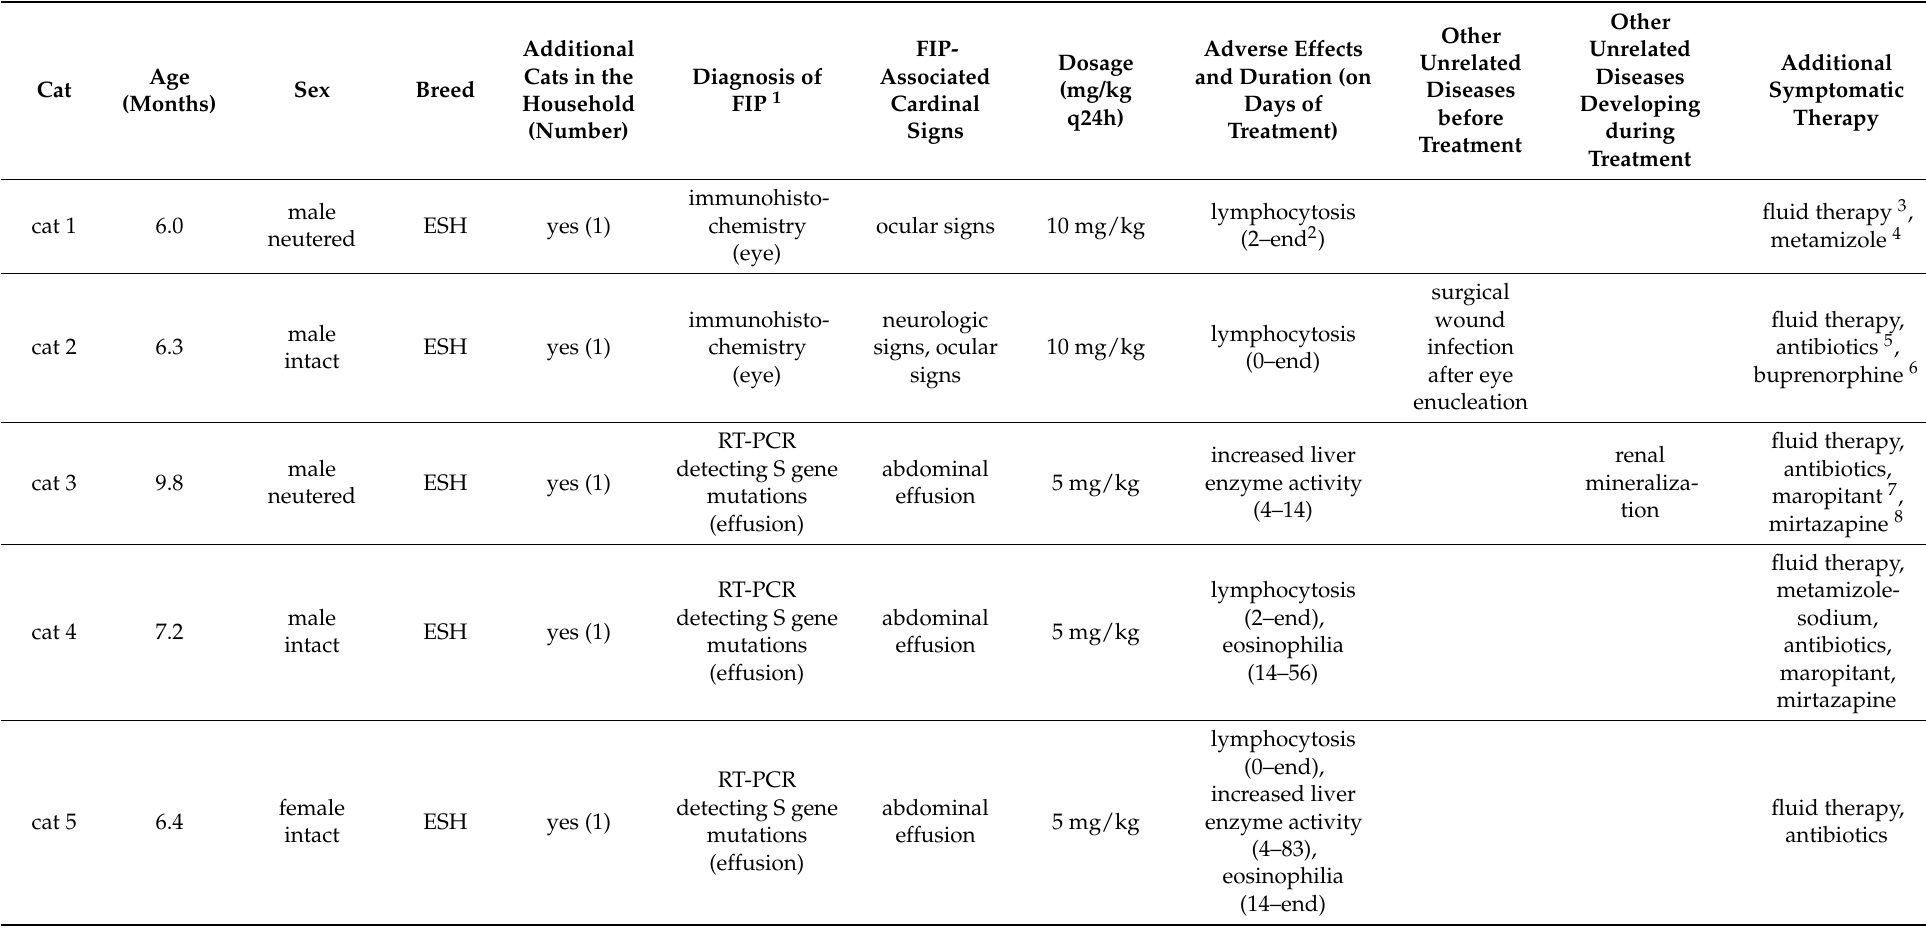
Table 1. Cats participating in the study, including signalment, number of additional cats in the household, method of diagnosis of feline infectious peritonitis (FIP), FIP-associated signs, Xraphconn ® treatment dose, other diseases at the start of and developing during treatment, adverse effects, and additional symptomatic